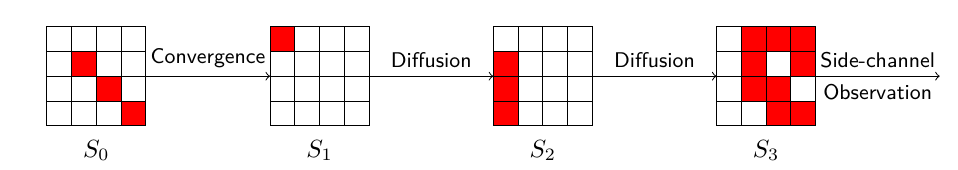
Figure 4: MIDORI differential pattern for 4-round attack. Active cells are in